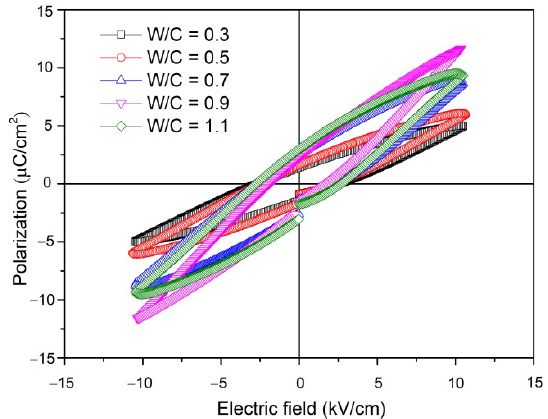
Figure 6. P – E hysteresis loops of the PZT–PC composites vs. water/cement ratio.